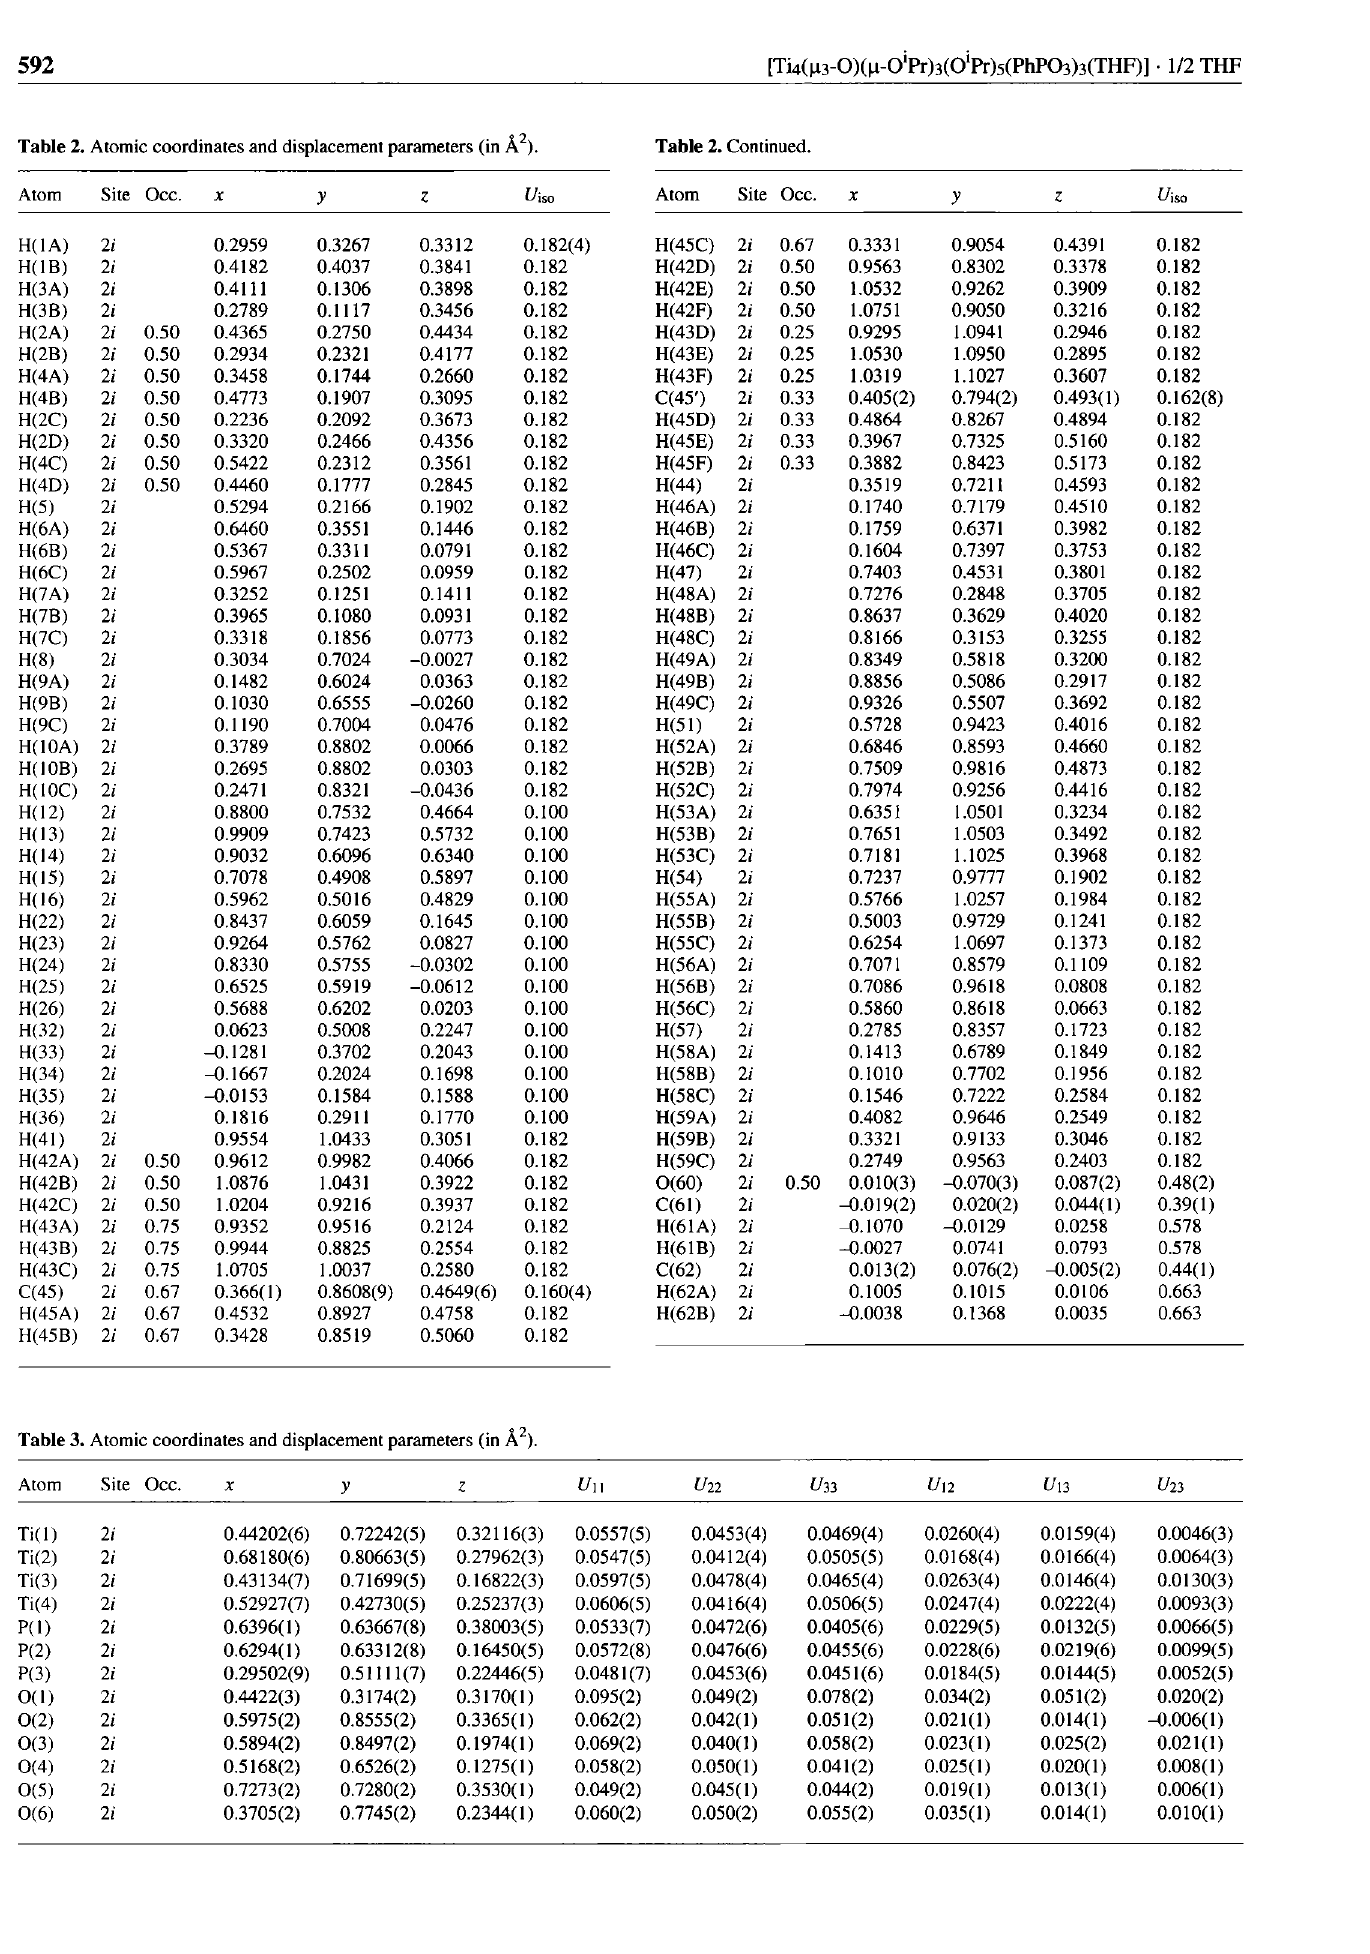
Table 2. Continued. Atom Site Occ.